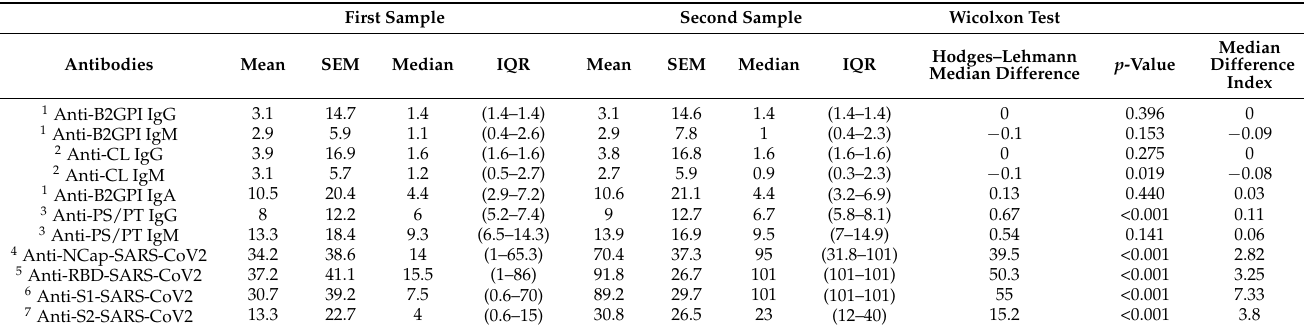
Table 2. Paired samples analysis (Wilcoxon test) of antiphospholipid and IgG anti-SARS-CoV-2 virus levels in serum of COVID-19 patients. Median difference index is calculated by dividing Hodges–Lehmann by the value of the median of the first sample.